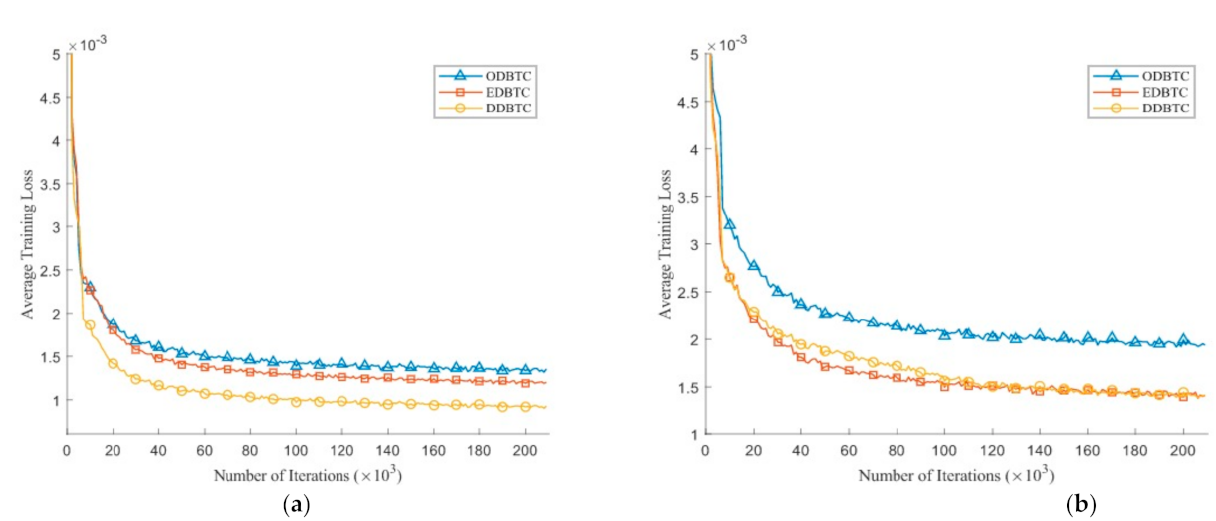
Figure 10. The average training loss of the proposed method over various H-BTC image blocks: ( a ) 8 × 8, and ( b ) 16 × 16.